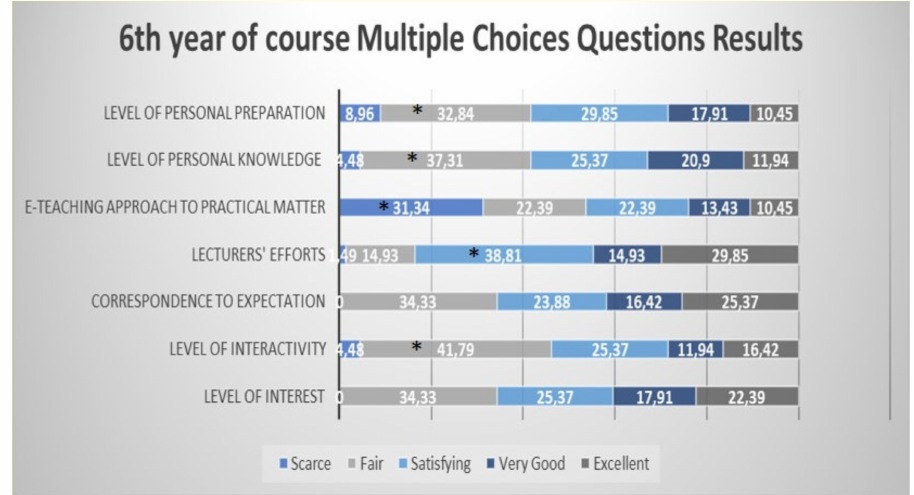
Figure 7. Questionnaire results for the sixth year student feedback to the e-learning and e-teaching approach. The numbers in the bars indicate the percentages of the answers received ( n = 301). * p < 0.05 (Pearson’s chi-squared tests). Although the level of interest and correspondence to expecta- tions were mostly defined as “fair”, the difference did not reach statistical significance.